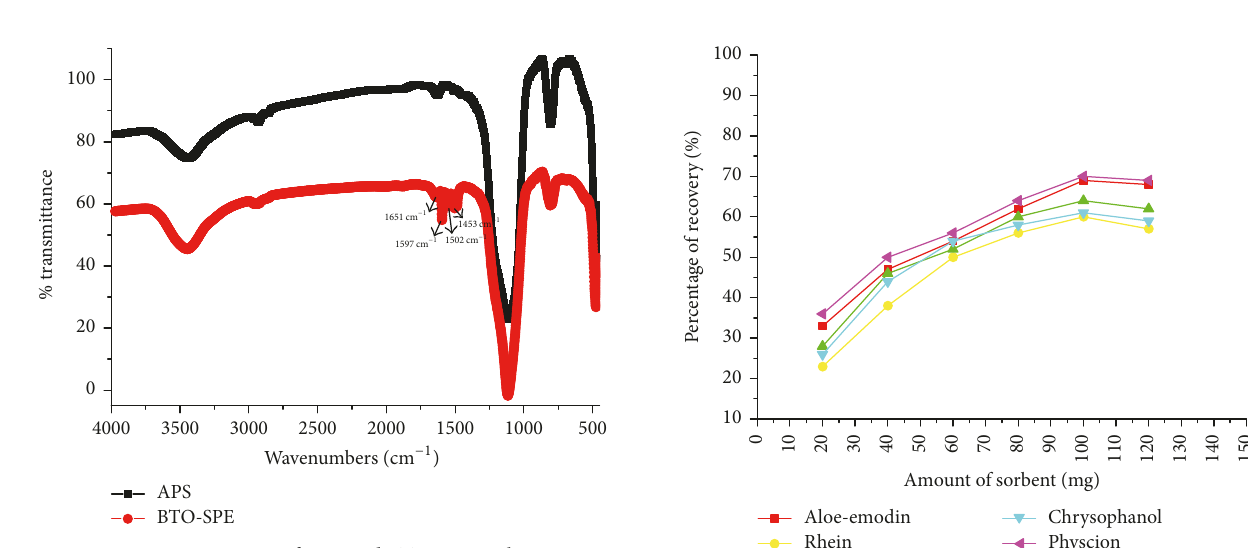
Figure 3: IR spectra of APS and BTO-SPE sorbent.